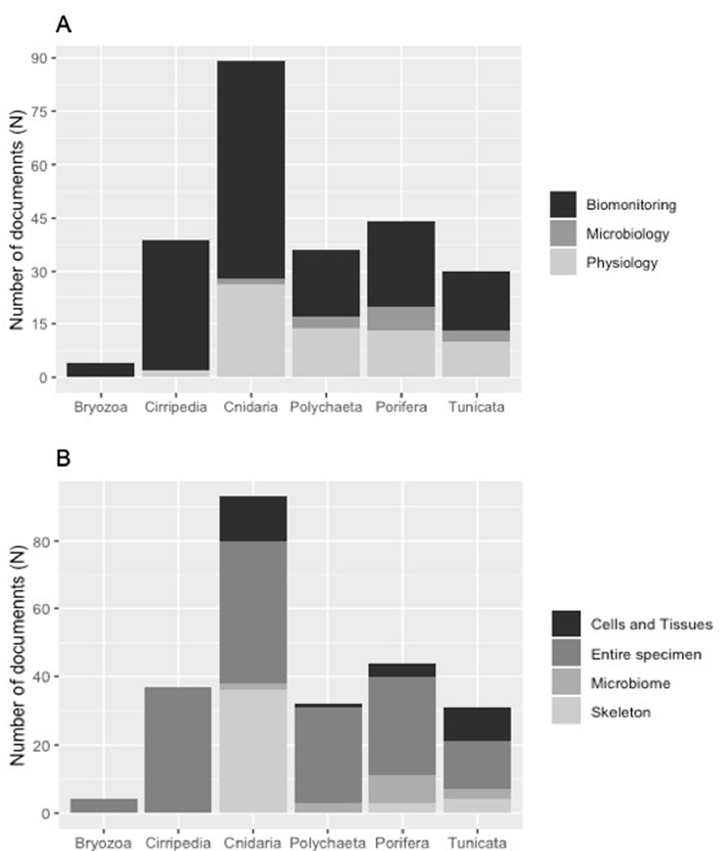
Figure 4. Number of documents per: ( A ) science field and ( B ) analyzed body part.